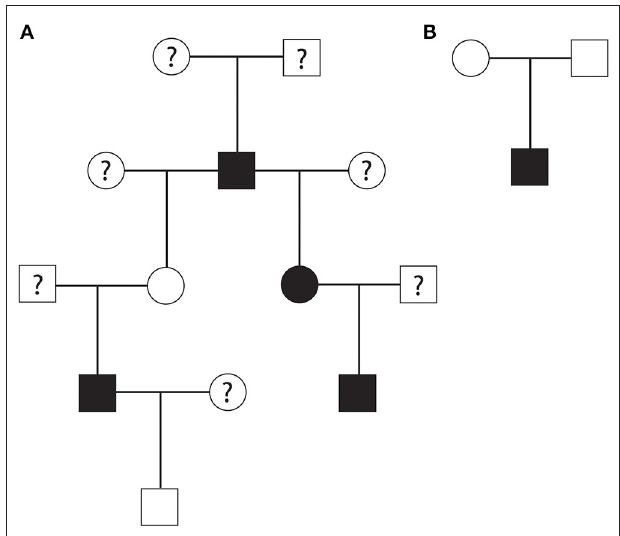
FIGURE 1 | (A) A part of rhesus macaque family pedigree that suggested an autosomal recessive mode of inheritance or autosomal dominant mode with incomplete penetrance for HCM. Another nuclear family pedigree (B) showing that non-HCM affected parents produced one HCM-affected male rhesus offspring suggesting autosomal recessive mode of inheritance. Square; male, circle; female, white; no HCM, black; HCM, question mark; unknown HCM